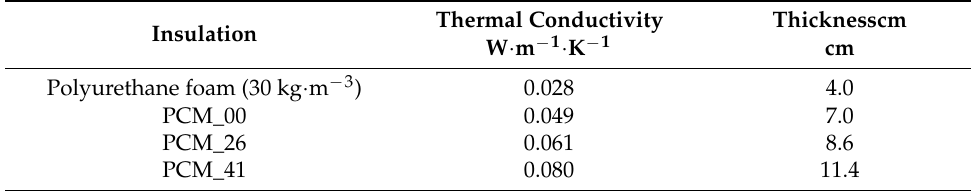
Table 4. Properties of the insulation (at 24 ◦ C).